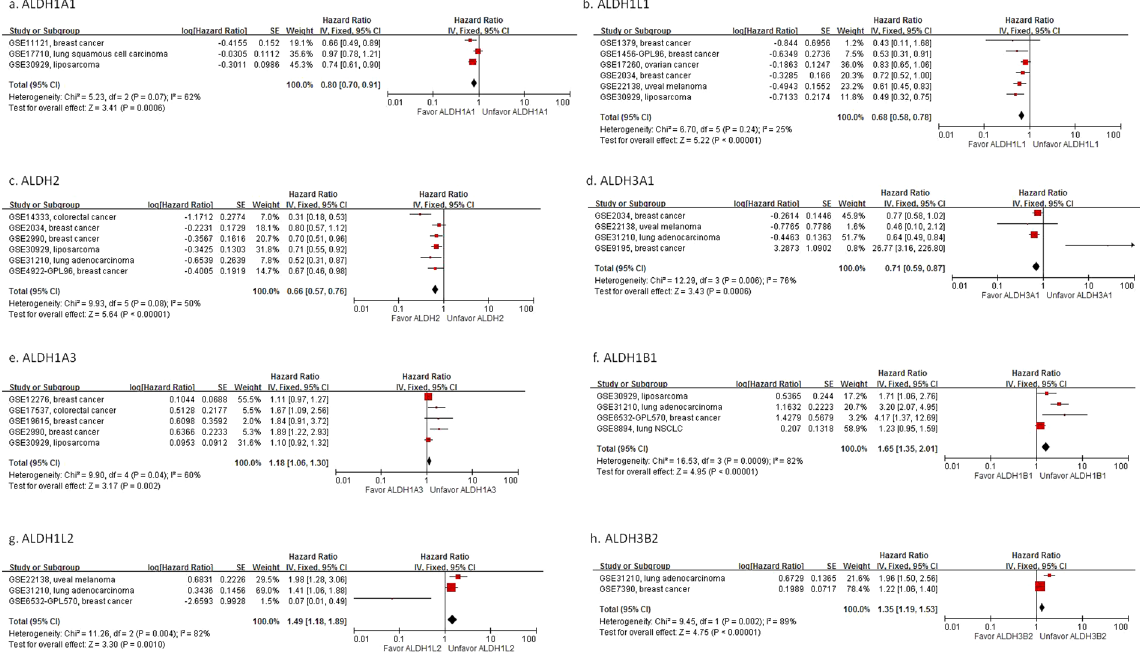
Figure 3. Meta-analysis of progression-free survival for different ALDH isoforms. “Favor” indicates expression of candidate ALDH toward better prognosis, whereas “Unfavor” indicates expression toward poorer prognosis. Lower expression of ALDH1A1, ALDH1L1, ALDH2, ALDH3A1, ALDH3A2, ALDH3B1, ALDH5A1, ALDH6A1 and ALDH9A1, whereas higher expression of ALDH1A3, ALDH1B1, ALDH1L2, ALDH3B2, ALDH8A1 and ALDH18A1 was associated with poorer progression free survival. ( a ) ALDH2; ( b ) ALDH3A1; ( c ) ALDH5A1; ( d ) ALDH6A1; ( e ) ALDH1B1; ( f ) ALDH1L2; ( g ) ALDH3B2; ( h )